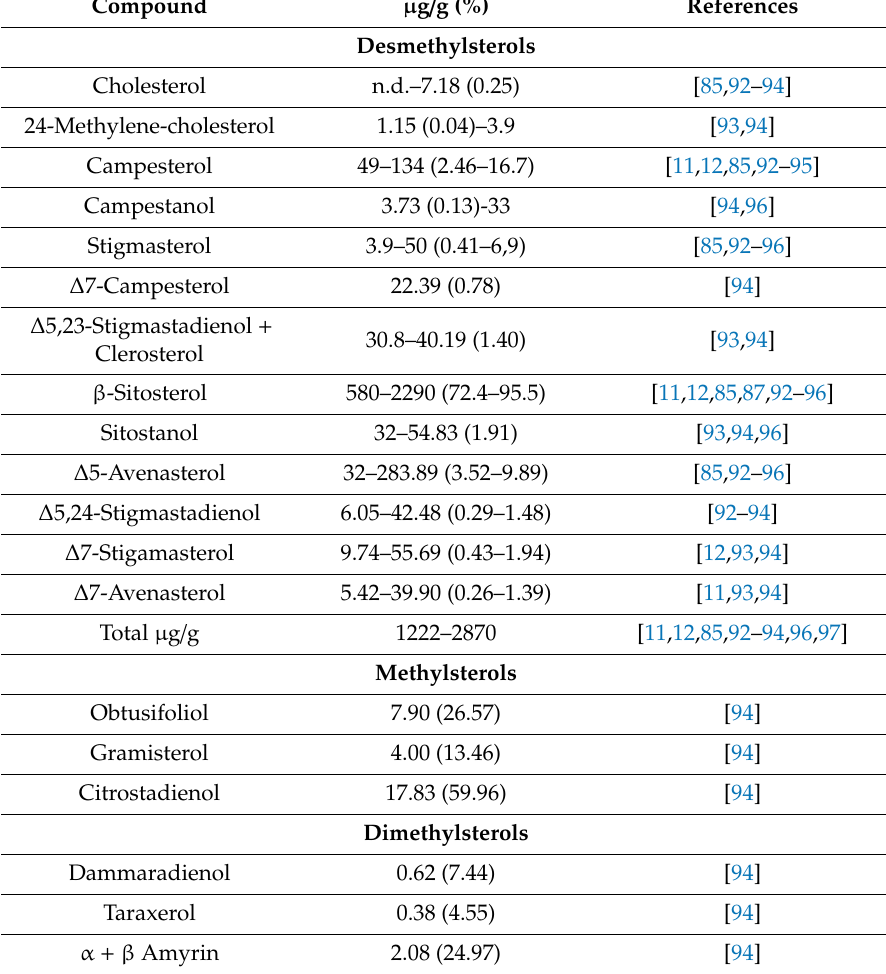
Table 4. Minor compounds: phytosterols, terpenic alcohols, squalene, aliphatic alcohols and